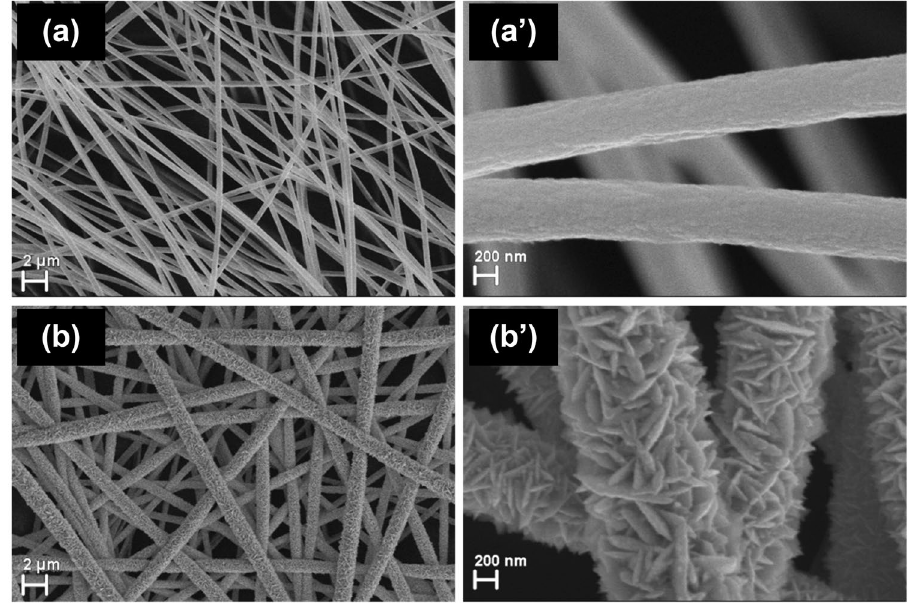
Figure 2. SEM images of ( a , a’ ) Au/PMMA/PET and ( b , b’ ) PdO/Pd/Au/PMMA/PET